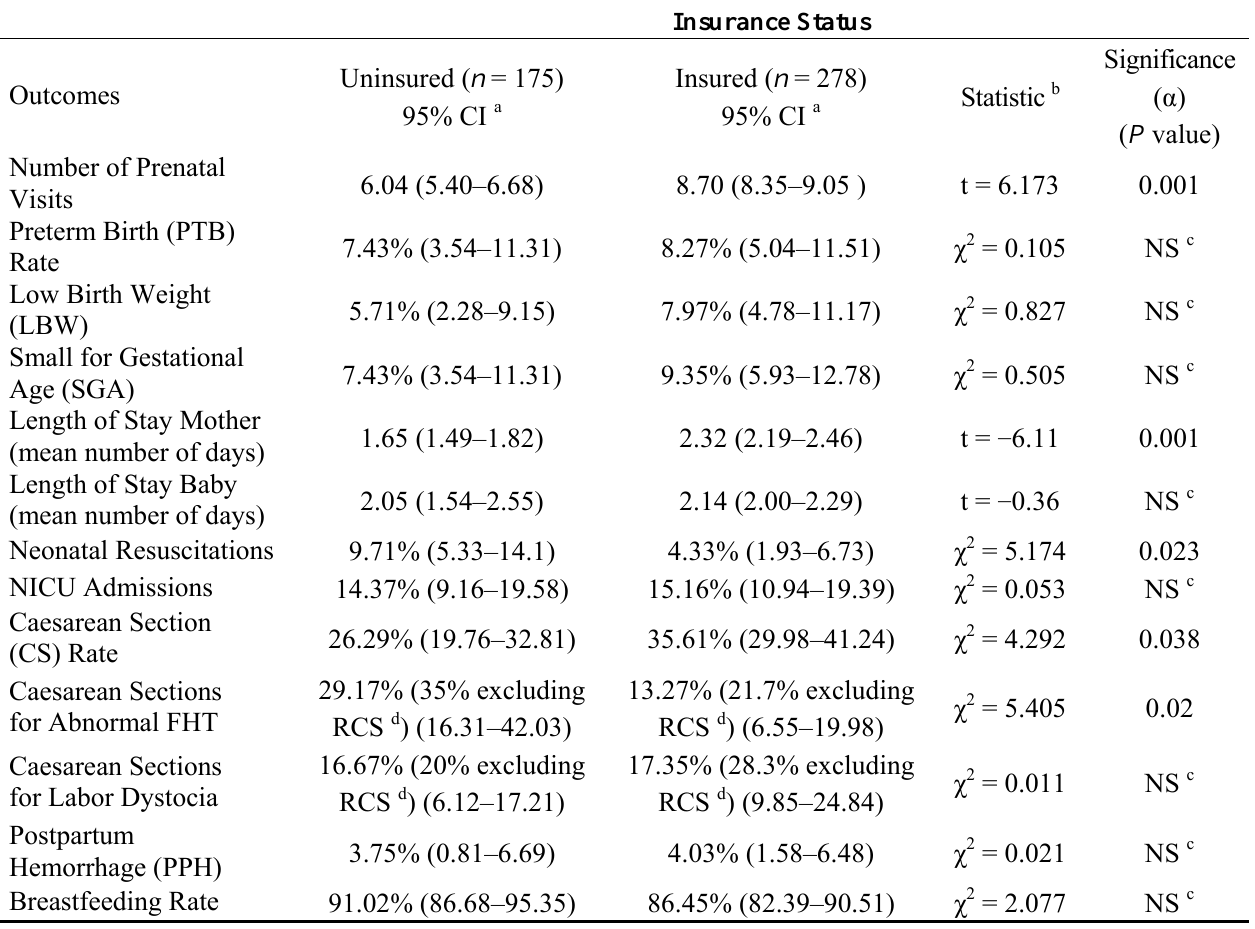
Table 2. Selected factors and perinatal outcomes of uninsured versus insured cases ( n =